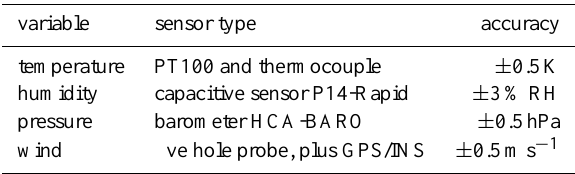
Table 3. MASC measurement equipment characteristics.